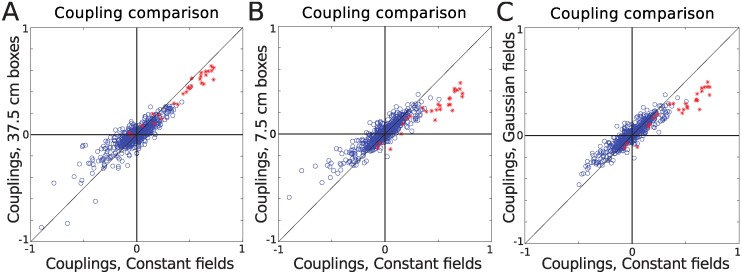
The couplings of the kinetic Ising model.We considered different forms of spatial external input to the neurons, boxes of length 37.5 cm (A), 7.5 cm (B) and fields formed as a weighted sum of Gaussian basis functions (C) for data set 1. For each case, we compared the resulting couplings to that of a model with spatially and temporally constant fields. The effect of input with spatial variation is to slightly weaken the couplings. Pearson correlation coefficient (PCC) was calculated for all the couplings together (All), as well as for just the self-couplings (SC) shown by red stars, and the non-self-couplings (NonSC) shown by blue circles. The corresponding values are A: PCC, All = 0.91, PCC, SC = 0.98, PCC, NonSC = 0.86. B: PCC, All = 0.91, PCC, SC = 0.94, PCC, NonSC = 0.90. C: PCC, All = 0.92, PCC, SC = 0.94, PCC, NonSC = 0.91.